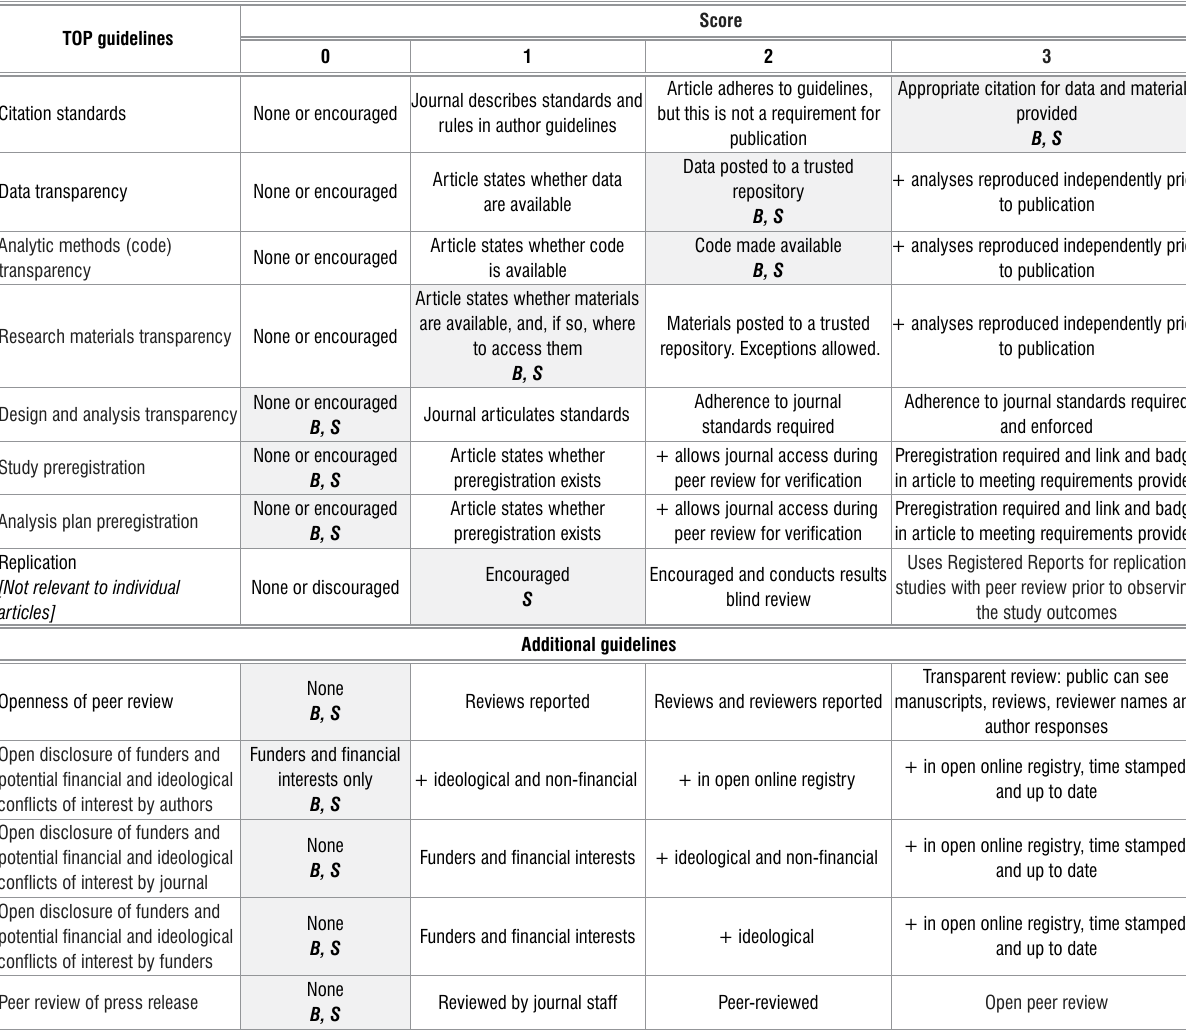
Table 2: A transparency scoring system for articles and journals based on the standards and levels of the Transparency and Openness Promotion (TOP) guidelines, type of peer review, and disclosure of financial and ideological conflicts of interest. The minimum standards implemented by Science are indicated with an S , while the score for the Bastin et al. 1 article is indicated with a B